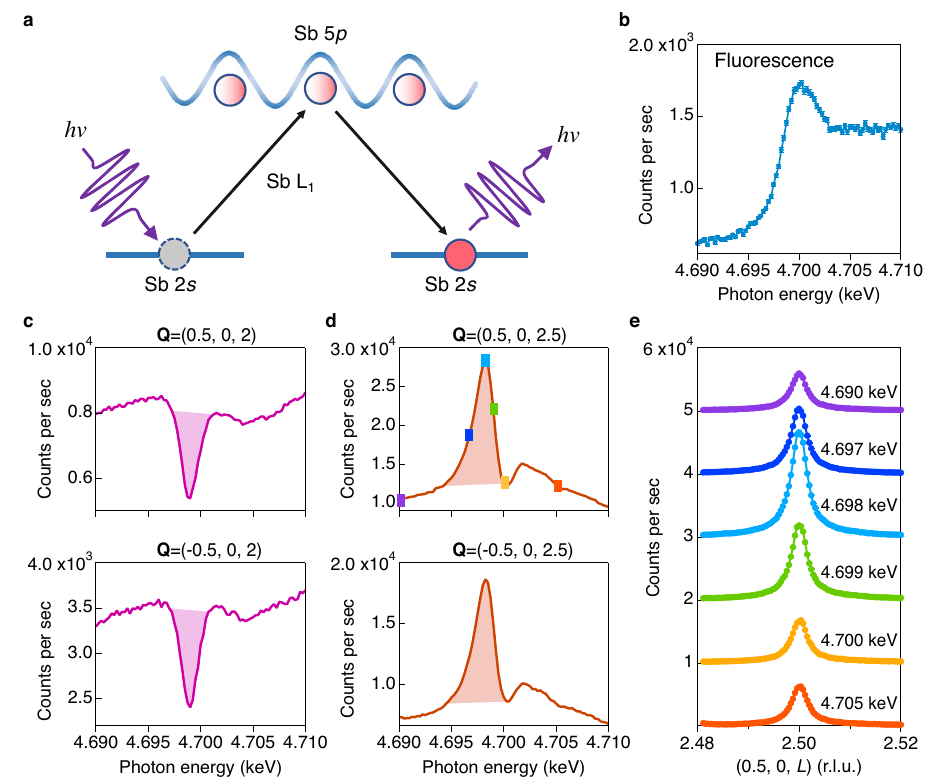
Fig. 2 | Sb L 1 -edge REXS reveals conjoined CDWs in CsV 3 Sb 5 . a Schematic of the REXS process. The Sb 2 s to 5 p transition is allowed by the dipole selection rule. b X-ray fl uorescence near the Sb L 1 -edge (4.7keV). c , d Photon energy scans at the Q 2×2×1 CDW = ð ±0 : 5,0,2 Þ and Q 2×2×2 CDW = ð ±0 : 5,0,2 : 5 Þ taken at T =10K. Resonant peaks